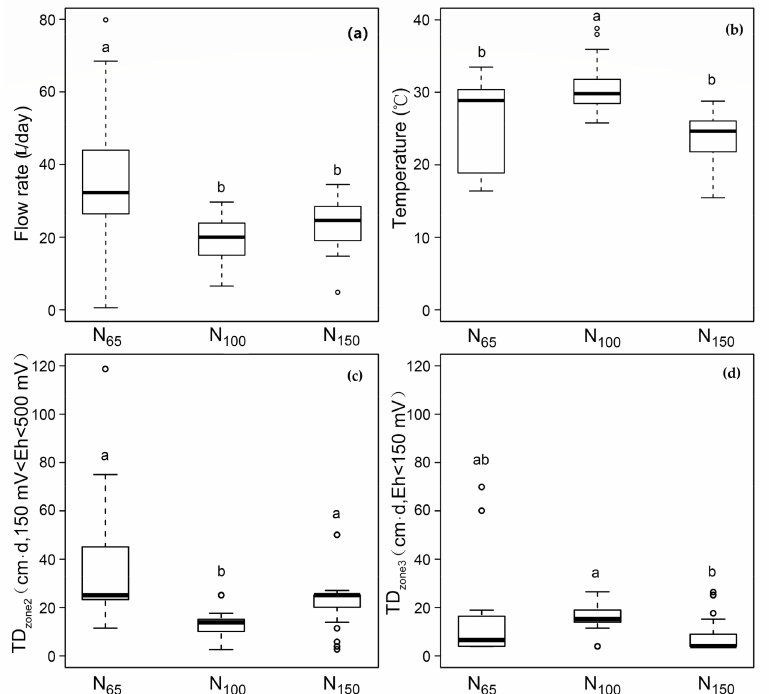
Figure 3. Boxplot of flow conditions, temperature, and thickness and time duration of redox zone (TD zone ) under different supplied nitrate concentrations of 65, 100, and 150 mg/L (N 65 , N 100 , N 150 , respectively). Two groups that are identified by the same letter (a, b or c) are not significantly different from each other. ( a ) flow rate; ( b ) Temperature; ( c ) TD zone2 (150 mV < Eh < 500 mV); ( d ) TD zone3 (Eh < 150 mV).